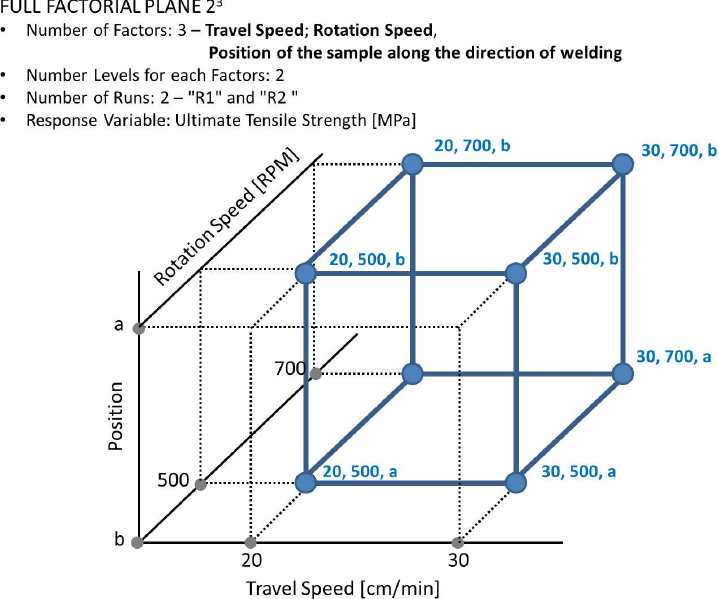
Figure 14. 2 3 experimental design. Figure 15: specimen a, placed at 120 mm from section A, and specimen b placed at 20 mm from section A.